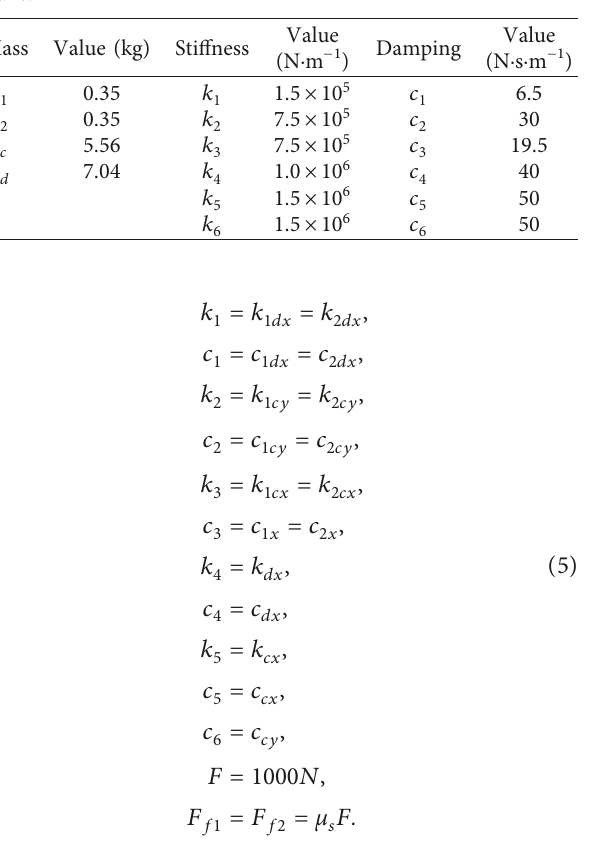
Figure 5: Schematic of fixed-caliper disc brake (a) and seven-DOF model (b) [26]. Table 2: Parameters used in system model of fixed-caliper disc